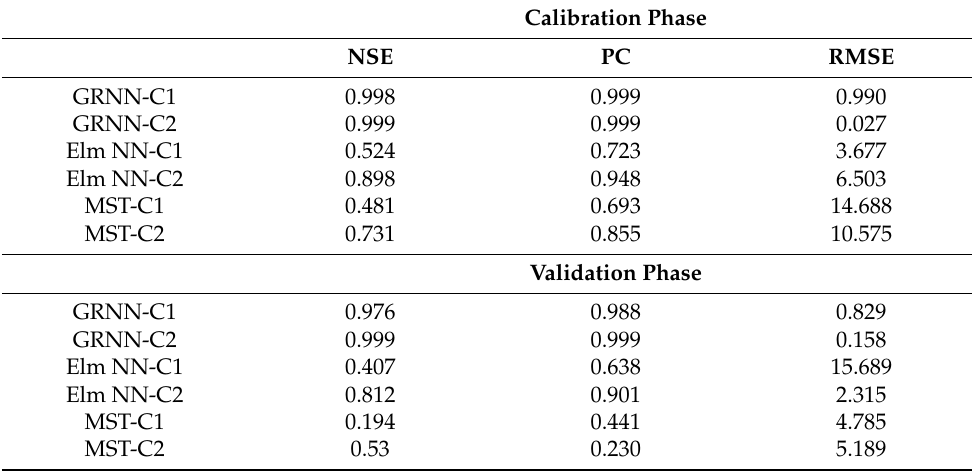
Table 2. Performance of the GRNN, Elm NN, and MST techniques.